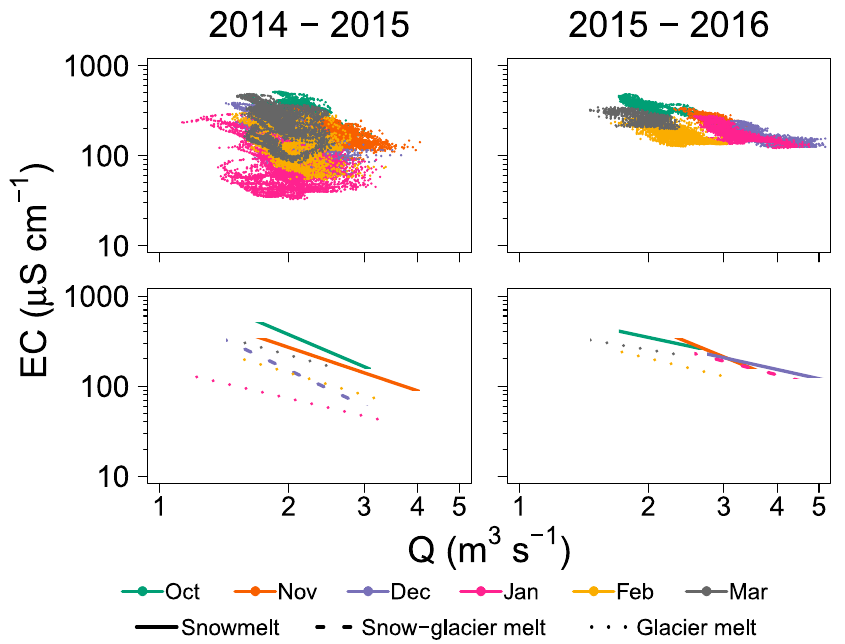
Figure 5. Water discharge (Q) and electrical conductivity (EC) relationship grouped by month in the two ablation seasons. The plots show the data points (above) and the regressions calculated by splitting the data series per month.